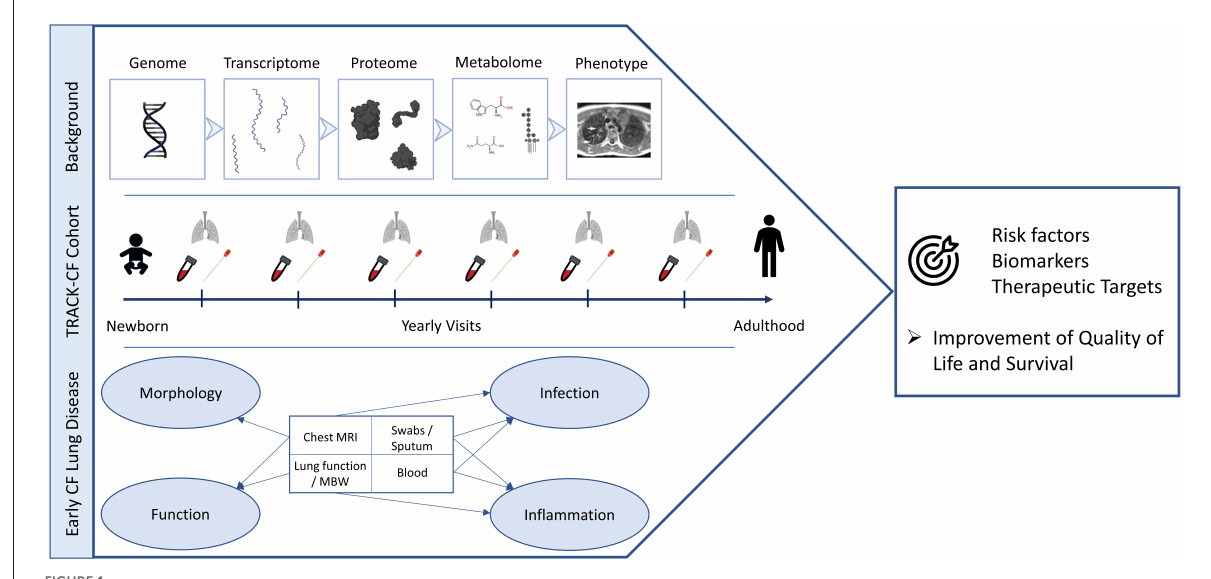
FIGURE1 TRACK-CF summary. The strategy to examine the different stages of CF lung disease development (“Background”) is presented on top. The study endpoints and regularly performed examinations from birth to adulthood are displayed in the center and the endpoints and covered aspects of early CF lung disease are shown at the bottom of the figure. The overall aims are to improve the quality of life and the survival through the identification of risk factors, biomarkers and novel therapeutic targets (right). This figure was created with